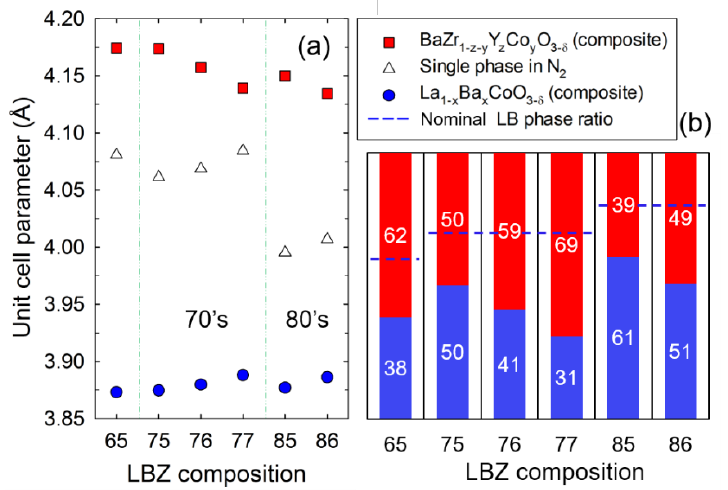
Figure 4. ( a ) Cubic unit cell parameters at room temperature of the single-phase material (open symbols) and the composite phases (red and blue symbols) and ( b ) phase ratio in LBZ materials obtained by Rietveld refinement. Blue dashed lines indicate the LB / BZ nominal phase